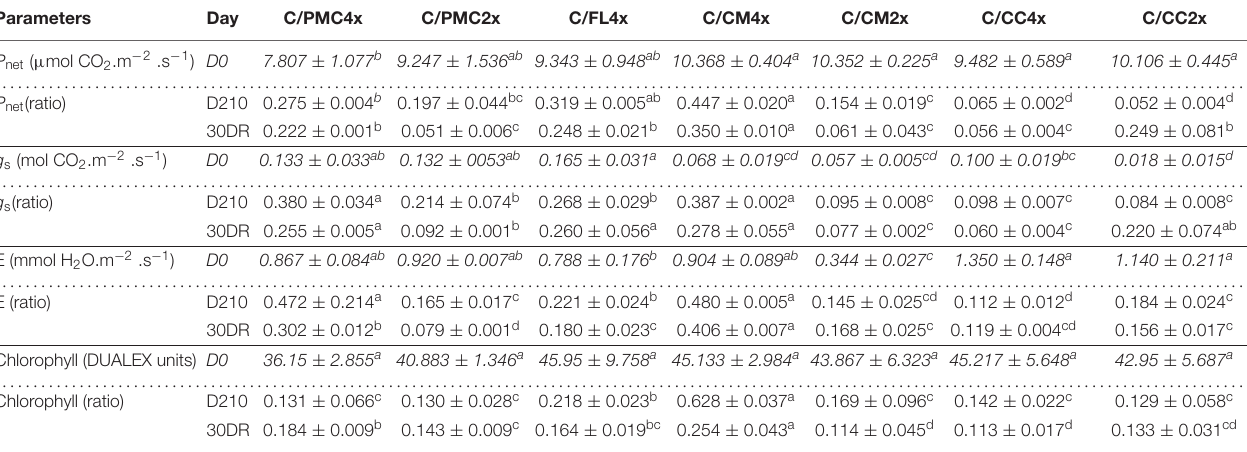
Data shown at D210 and 30DR are means (n = 3 ± standard error) expressed as ratios with respect to the values obtained on control which have not been subjected to stress. For further informations, means values of control data (D0) (n = 3 ± standard error) were also included and indicated by italics characters. Data were analysed using ANOVA and Fisher LSD tests (P < 0.05). Different letters indicate significant differences between genotypes along the time course. D0, control, D210, 210 days after the start of nutritional deprivation, and 30DR, after 30 days of recovery. TABLE 4 | Chlorophyll a fluorescence parameters of the seven scion/rootstock combinations after 210 days of nutrient deficiency (D210) and 30 days of recovery (30DR). Parameters